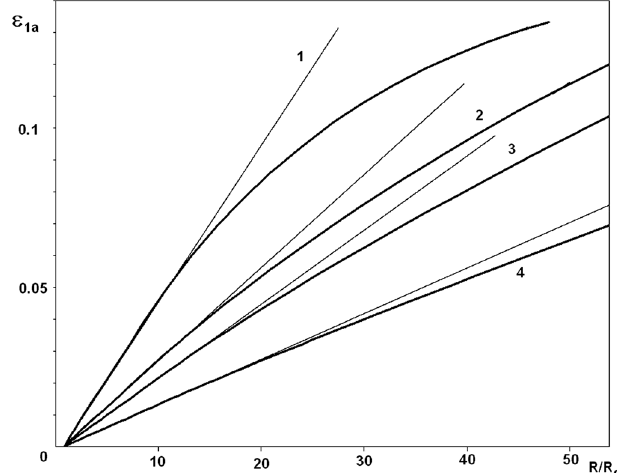
FIG. 4. The partial probability of volume capture ε 1 a [see Eq. (17) for the (110) silicon plane as a function of the relation R=R c for different energies 50 GeV (1), 400 GeV (2), 1000 GeV (3), 7000 GeV (4). The straight lines near curves are linear approximations (see Eq.